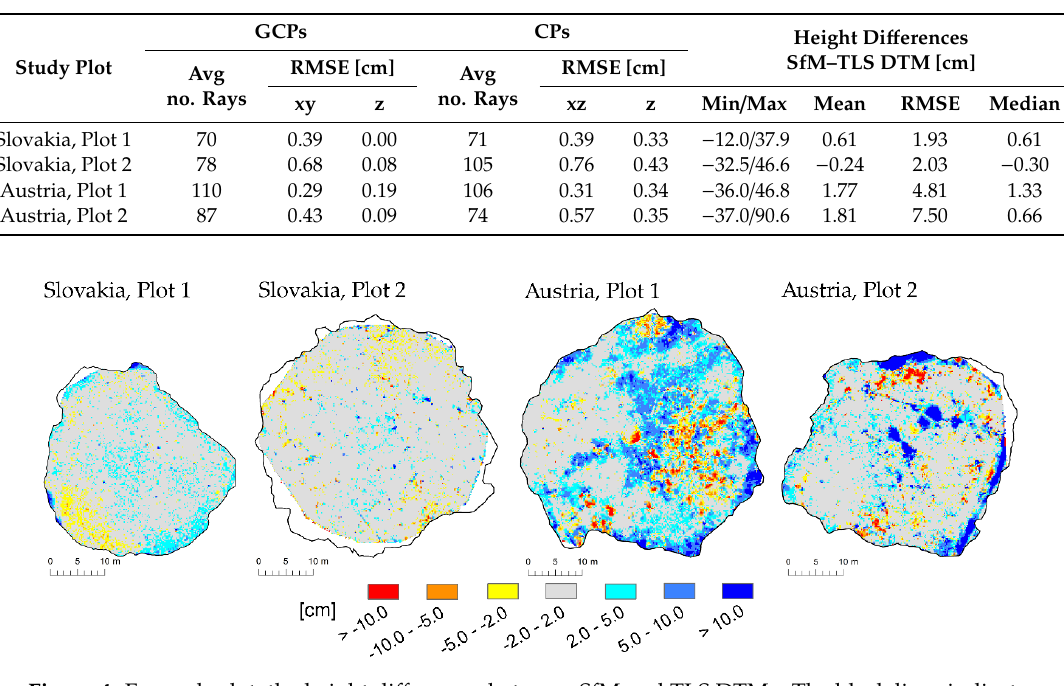
Figure 4. For each plot, the height differences between SfM and TLS DTMs. The black lines indicate the plot boundaries defined by the camera path around the plot.